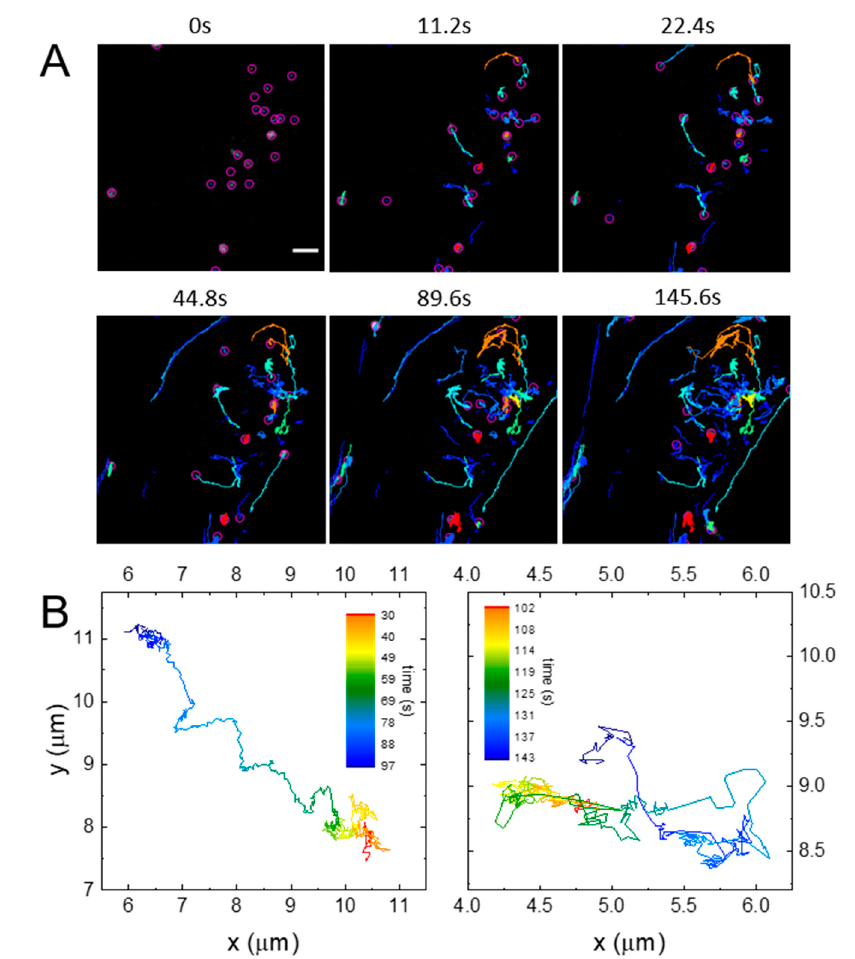
Figure 5. ( A ) Representative images from time-lapse video of moving lysosomes within a differentiating NSC. Each colored trace represents trajectories traveled by different lysosomes. Scale bar, 2 µ m. ( B ) Exemplary lysosome trajectories at DIV5. The color of the trajectories scales with time.